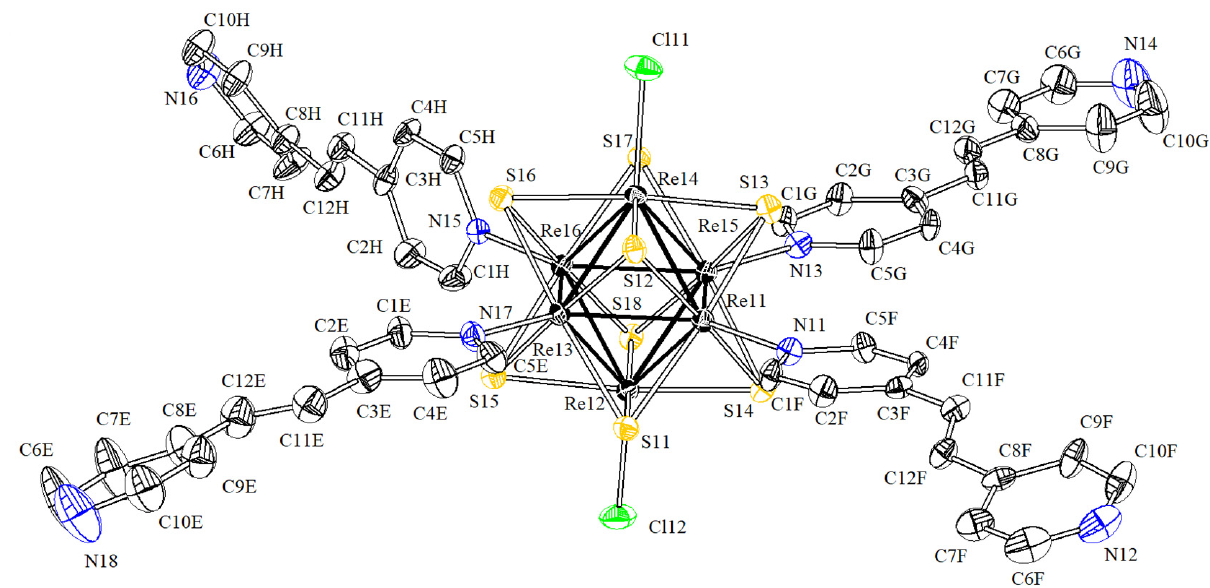
Figure 2. Molecular cluster [Re 6 S 8 (bpe) 4 Cl 2 ] in the structure of compound 1·solv . The ligands of neighboring cluster fragments overlap and form π -interactions with distances between aromatic rings centroids of 3.78 Å. Short contacts are also formed between µ 3 -S ligands with a length of 3.30 Å (Figure S2, Supplementary Material). The packing of compound 1 · solv is formed by these dimeric fragments linked with solvate bpe molecules due to C–H . . . π interactions with lengths of 3.67–3.40 Å. The centroids of the metal clusters are located on the (111) axis. Additionally, these fragments are interconnected through one solvate molecule using π -stacking, with an N-centroid distance of 3.53–3.65 Å. Thus, they form layers of metal clusters in the (011) plane (Figure 3). The relative orientation of ligands within one cluster fragment is determined by packing.